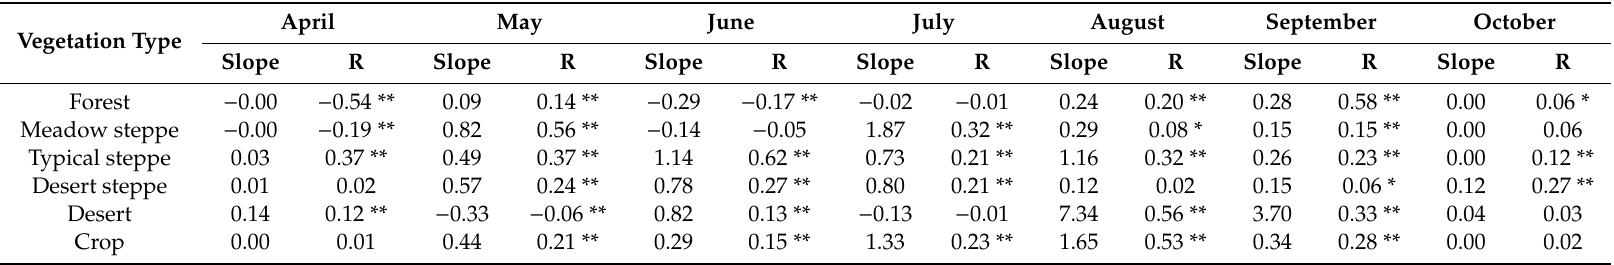
Table 1. Relationships between the CVs of monthly temperature and those of the NDVI for di ff erent biomes in Inner Mongolia from 1982 to 2015. Vegetation Type